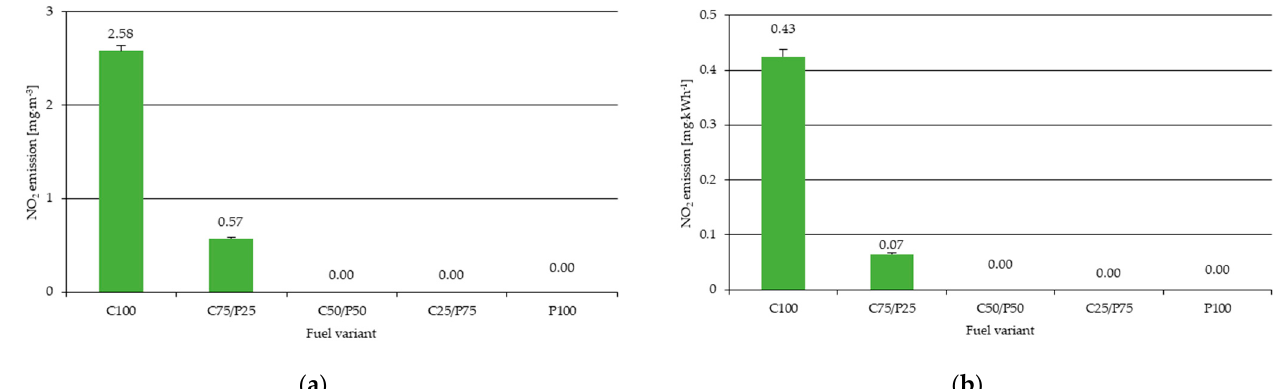
Figure 10. NO 2 emission per ( a ) 1 m 3 exhaust gas; ( b ) 1 kWh thermal energy.